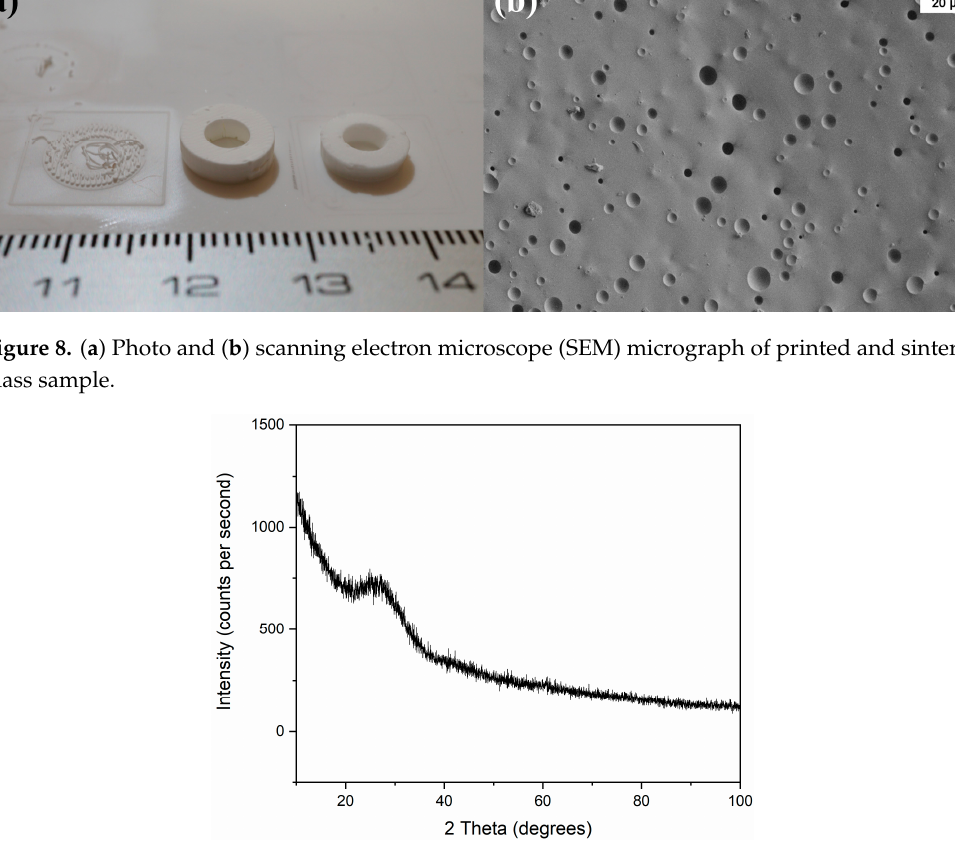
Figure 9. X-ray diffraction (XRD) pattern of printed and sintered glass sample. Figure 9. X-ray di ff raction (XRD) pattern of printed and sintered glass